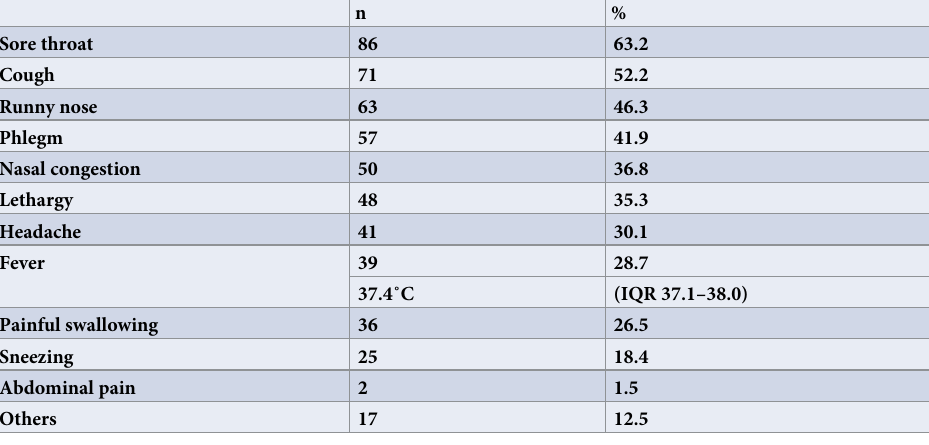
Table 2. Patients’